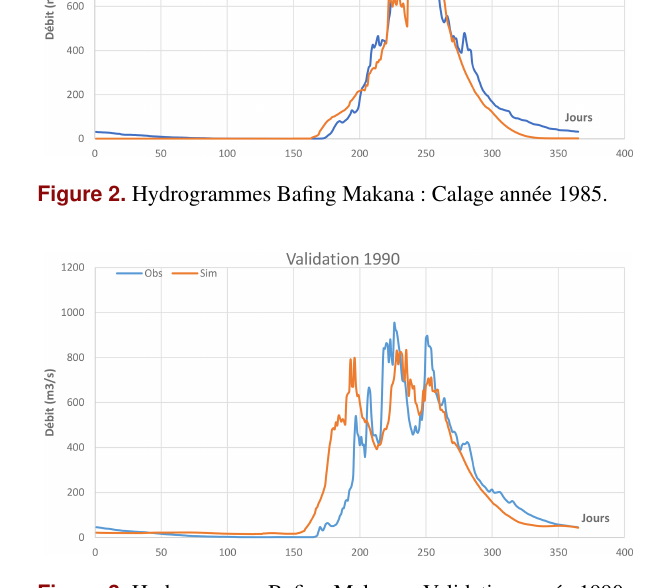
Figure 3. Hydrogramme Bafing Makana : Validation année